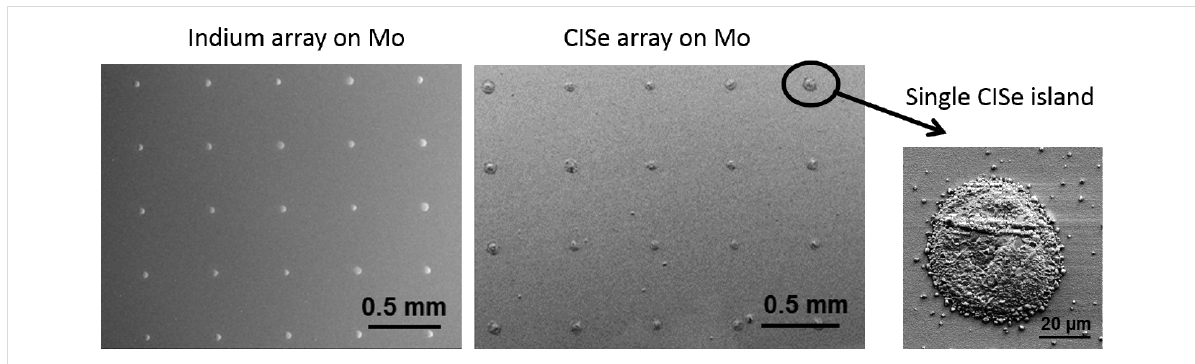
Figure 11: Processing of In precursor islands prepared by the nucleation approach (left) to CISe micro absorbers (middle and